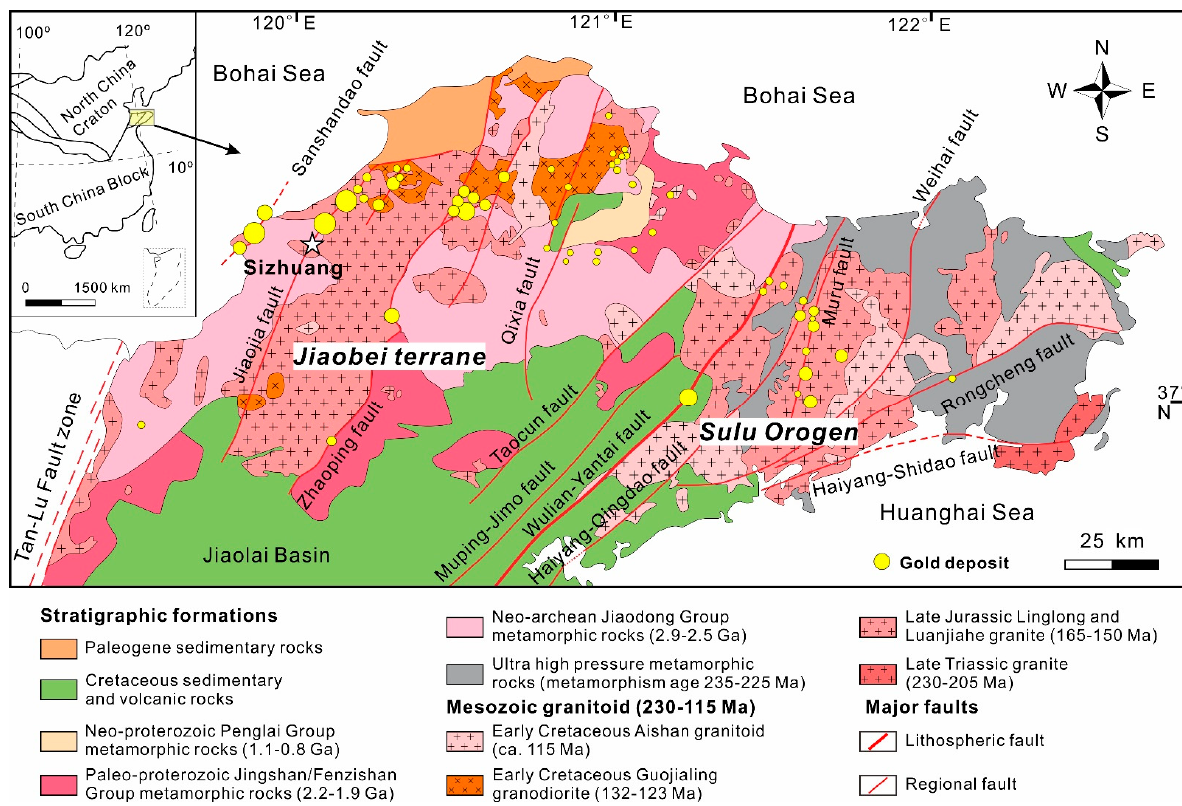
Figure 1. Simplified map showing the tectonic units, structures, lithologies, and major gold deposits in the Jiaodong Peninsula and the location of the Sizhuang gold deposit. (Modified from [18]).